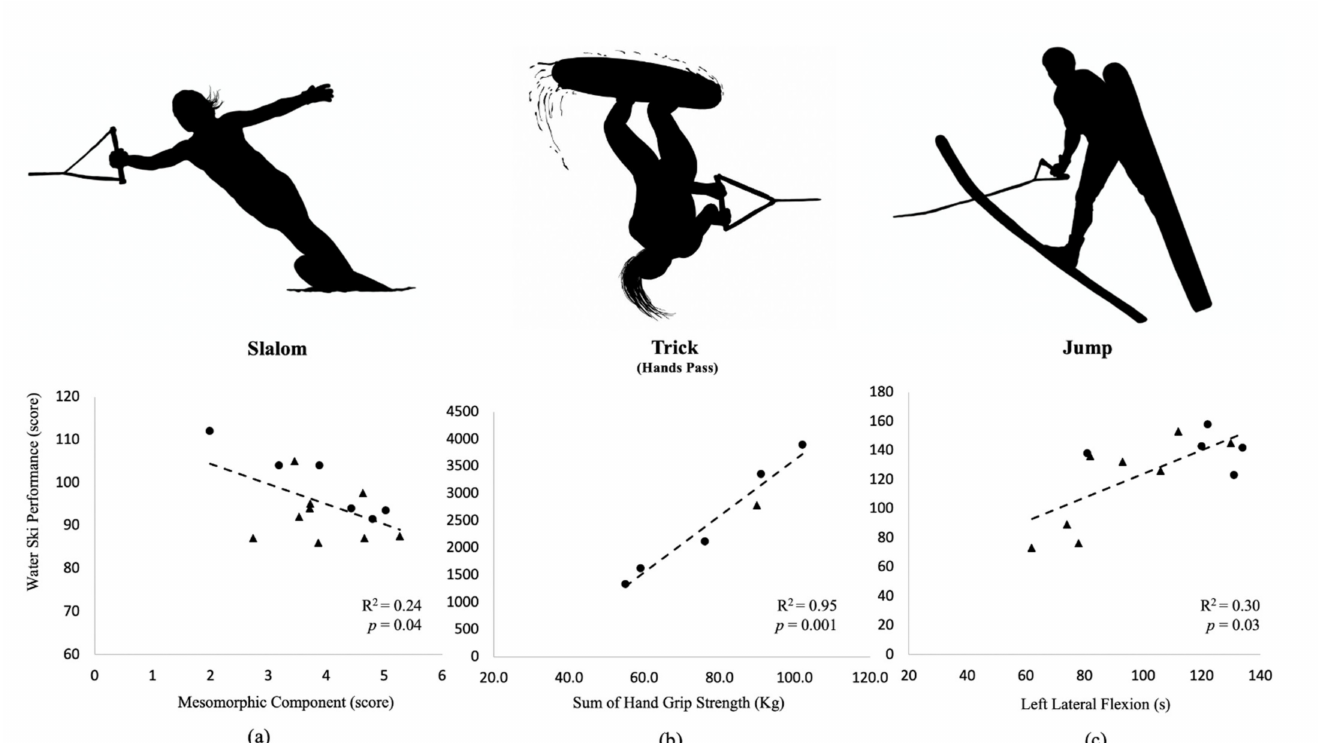
Figure 2. A regression analysis between selected factors and water ski performance in slalom, trick, and jump. Note: Circle represents a male water skier; triangle represents a female water skier. ( a ) a result of regression analysis between slalom performance score and mesomorphic component; ( b ) a result of regression analysis between trick hand pass performance score and sum of hand grip strength; ( c ) a result of regression analysis between jump performance score and left lateral